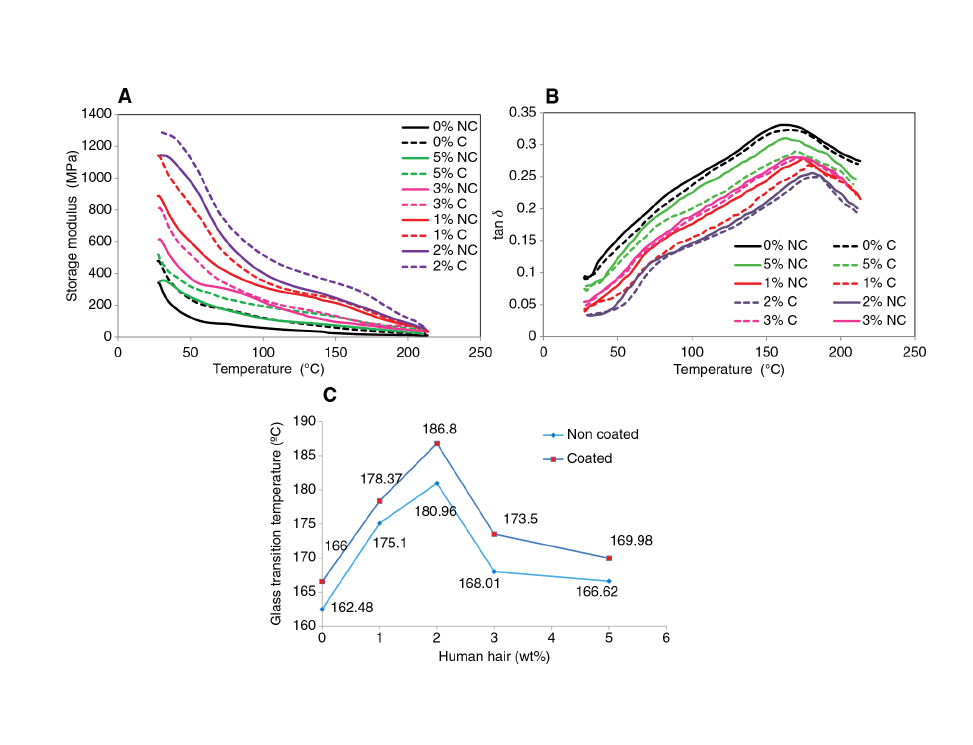
Figure 4: Result of dynamic mechanical analysis (A) storage modulus (B) tan δ and (C) glass transition